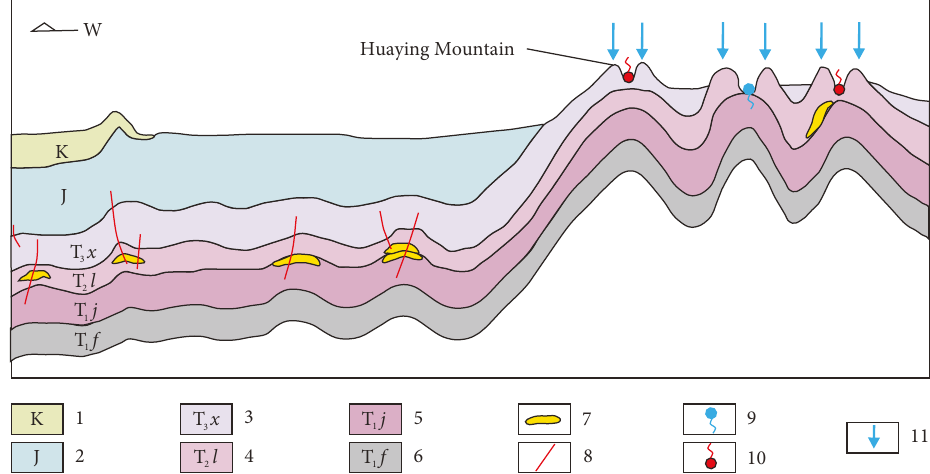
Figure 7: Schematic nearly east-west pro fi le showing the saline and salty springs in the central and eastern Sichuan Basin (modi fi ed from Xun et al. [57]). 1: Cretaceous glutenite and mudstone; 2: Jurassic sandstone and mudstone; 3: Upper Triassic shale, mudstone interbedded with siltstone, and sandstone; 4: Middle Triassic carbonate interbedded with evaporites; 5: Lower Triassic carbonate interbedded with evaporites; 6: gypsum (anhydrite) and halite; 7: fault; 8: cold spring; 9: saline or salty spring; 10: